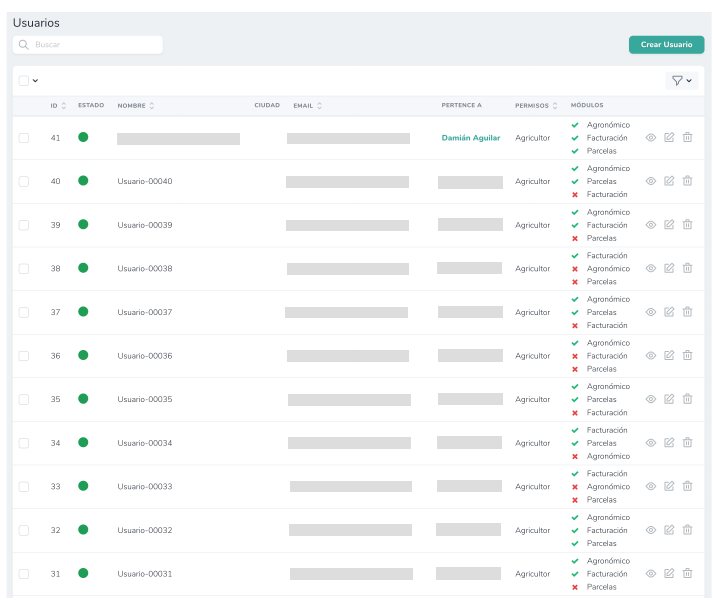
Figure 16. Roles and permission administration. Personal data has been removed from the image.